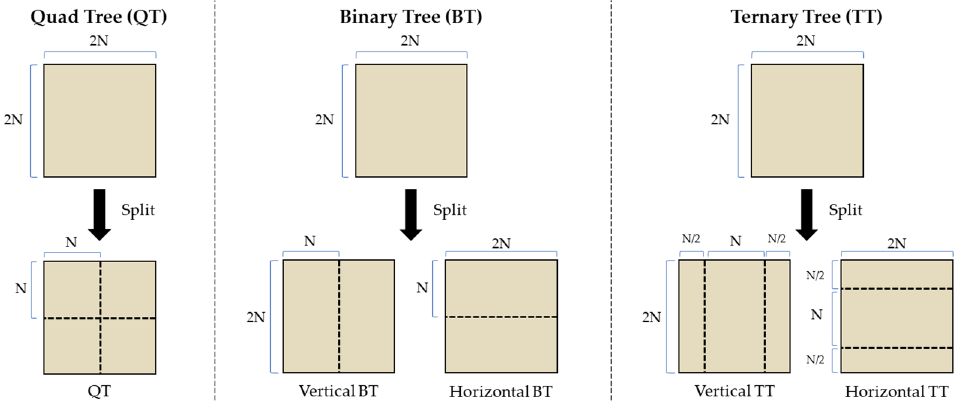
Figure 1. VVC block structure (QTMTT).